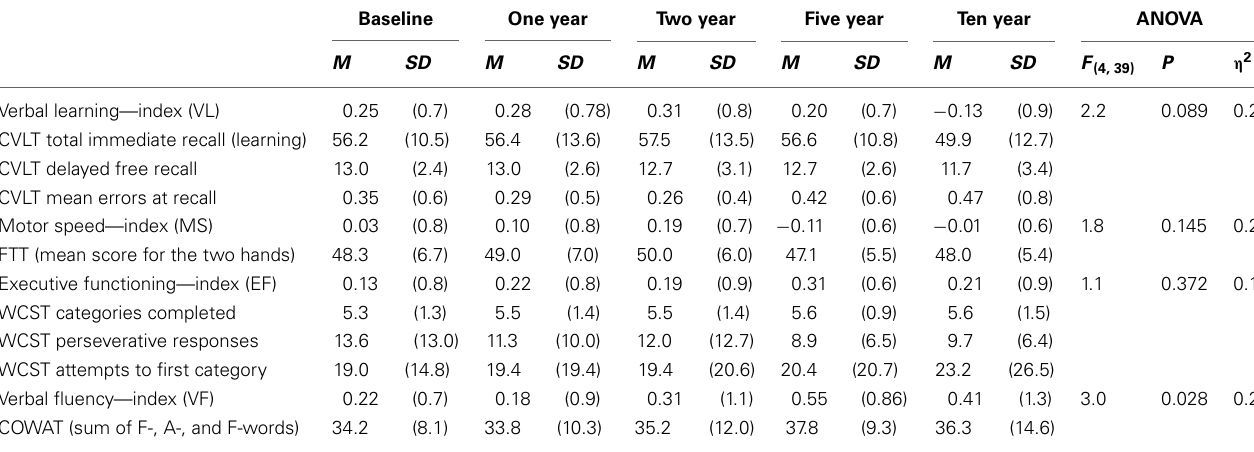
Table 1 | The four neurocognitive indices with the corresponding subtests and raw scores at each time point for the follow-up sample.